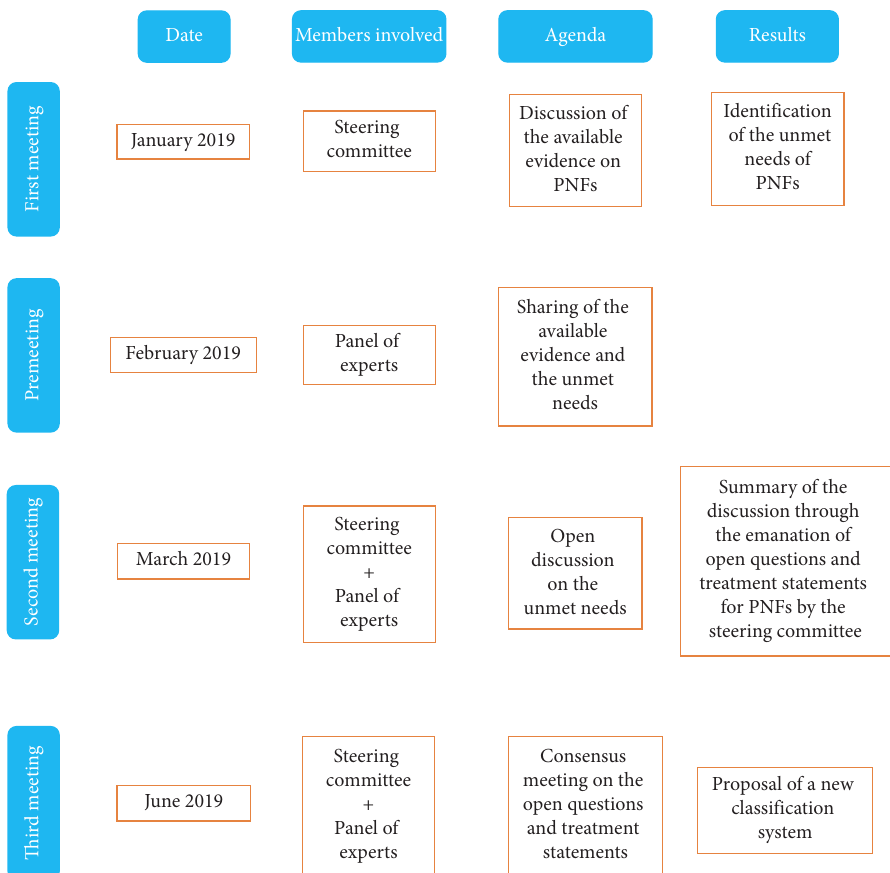
Figure 1: Summary of the entire procedure done to obtain the consensus for the classification